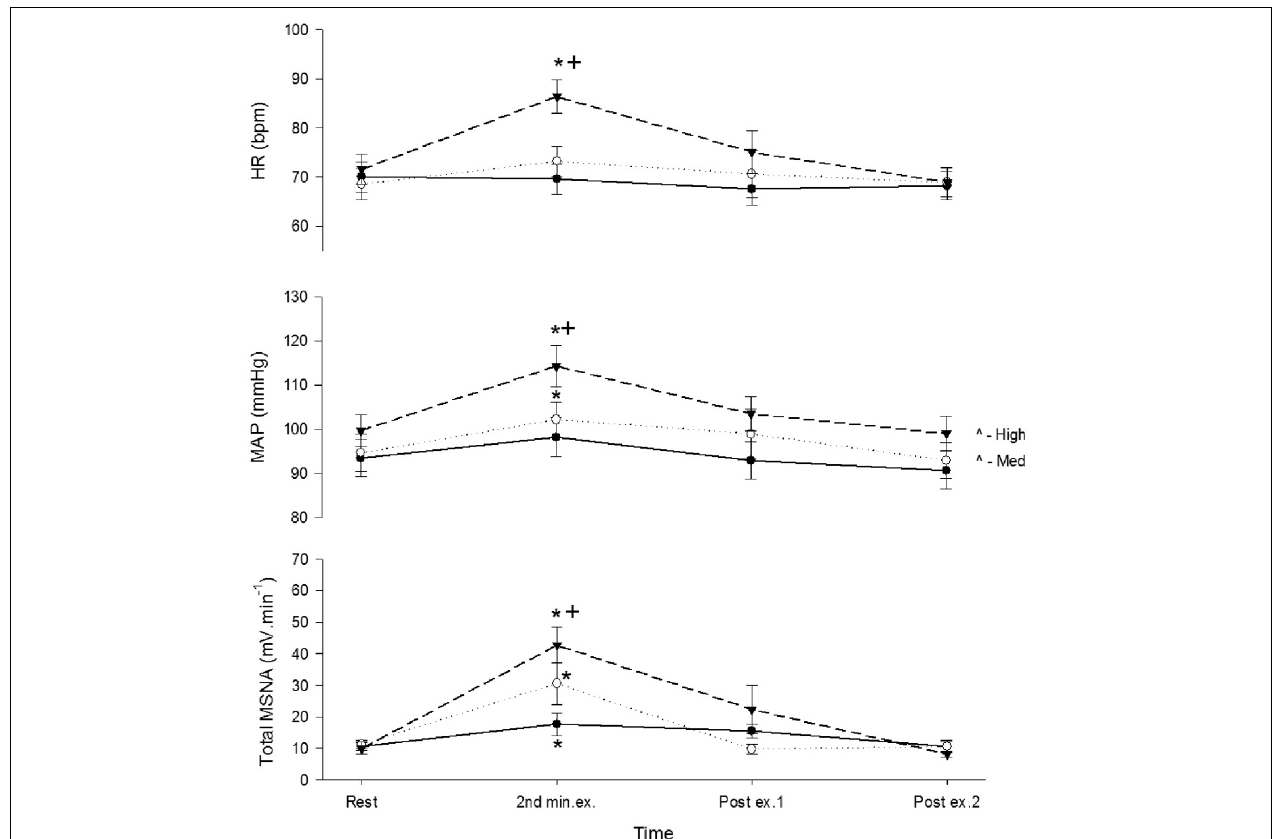
FIGURE 4 | Total MSNA, mean arterial pressure (MAP), and heart rate (HR) before, during, and after control contractions at low (closed circle), medium (open circle), and high intensities (triangle). Observations were made at rest, during the second minute of contraction, and during the first